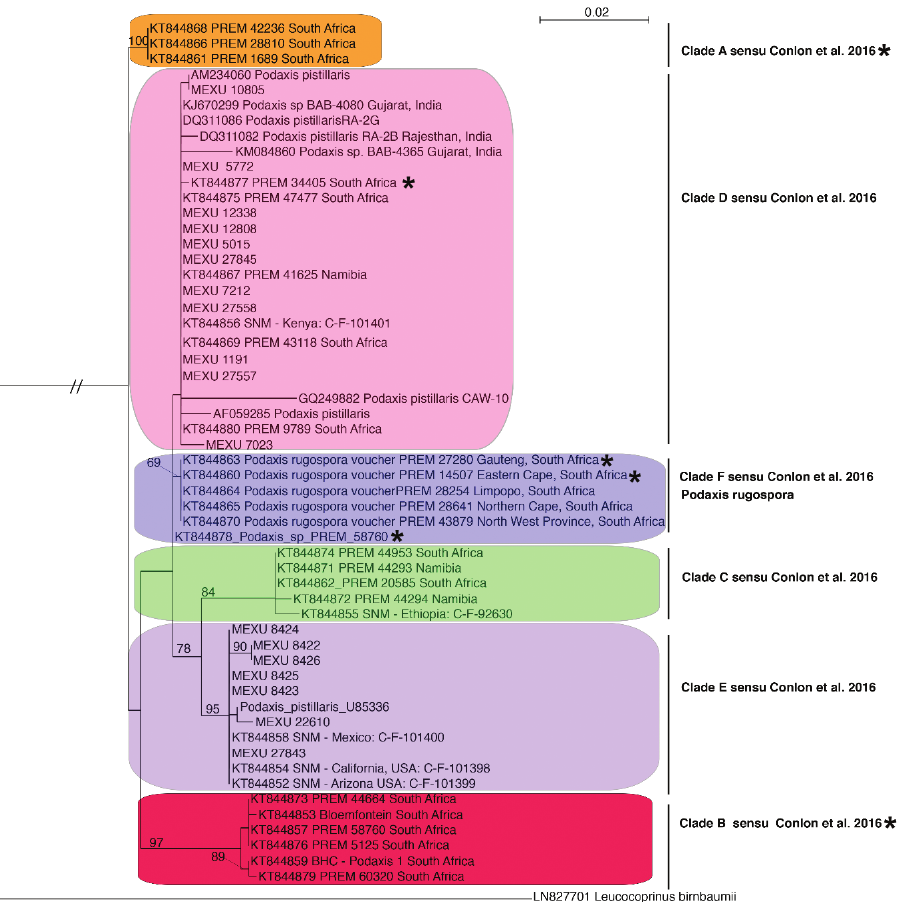
Figure 4. Phylogram of the most likely tree (-lnL = 1860.99) from a RAxML analysis of 56 taxa based on ITS rDNA (681 bp). Numbers above the nodes refer to RAxML bootstrap support values ≥ 70% based on 1000 replicates. Clades to the right ( A–F ) are labeled as per Conlon et al. 2016. The tree is rooted with Leucocoprinus birnbaumii. Symbol ( * ) next to collections indicates, it was reported from termite mounds. Bar indicates nucleotide substitutions per